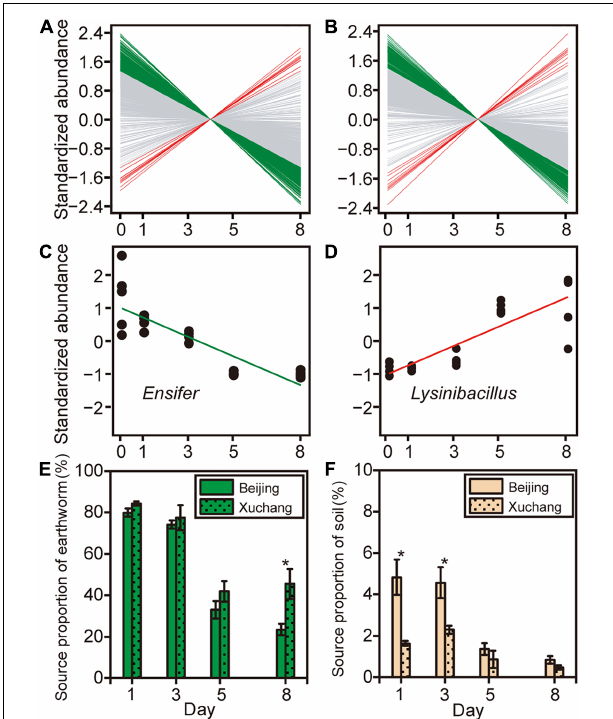
FIGURE 6 | The abundance of specific bacterial genera changed as decomposition proceeded in native soil (A) and non-native soil (B) . Green lines indicate that the abundance of bacterial genus significantly decreased with time ( p < 0.05), red lines indicate that the abundance of bacterial genus that significantly increased ( p < 0.05), and gray lines indicate that there was no significant change in bacterial abundance over time ( p > 0.05). Two representative genera, Ensifer (C) and Lysinibacillus (D) , were selected to show the relationships between taxonomic abundance and decomposition time. Source tracking was used to quantify the proportion of the likely source environments (source), earthworm-derived (E) and soil-derived (F) , to the microbial community on decaying earthworm. Asterisks indicate significant differences in the contribution of likely source between native soil and non-native soil treatments (independent samples t -test, p <